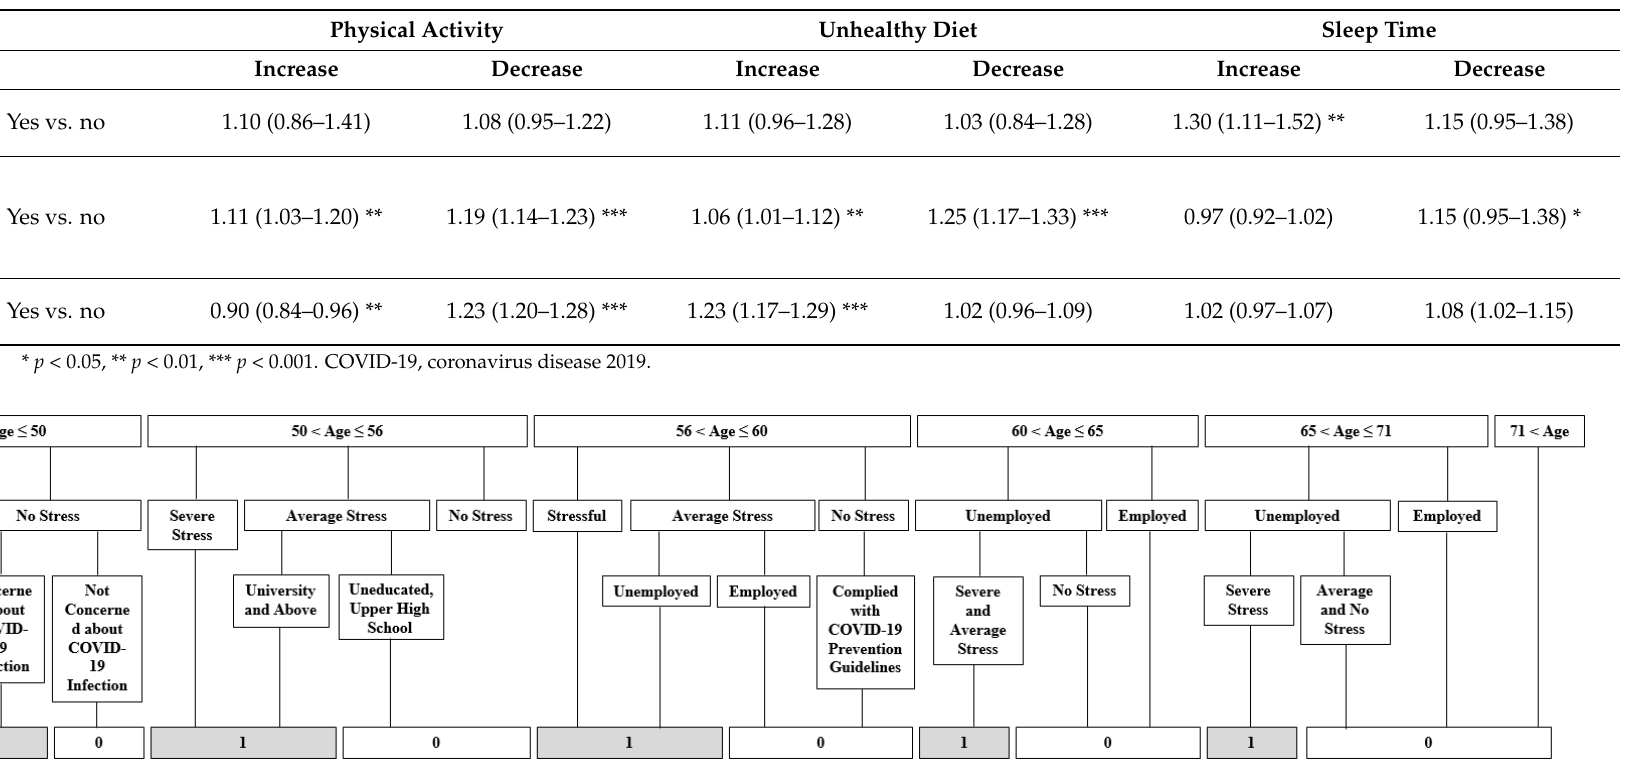
Figure 1. Classification and regression tree (CART) model to predict the occurrence of adverse health behaviors. 0, positive changes in health behaviors. 1, adverse changes in health behaviors. Table 3. Relationships of participant characteristics with changes in health behaviors during the COVID-19 pandemic.